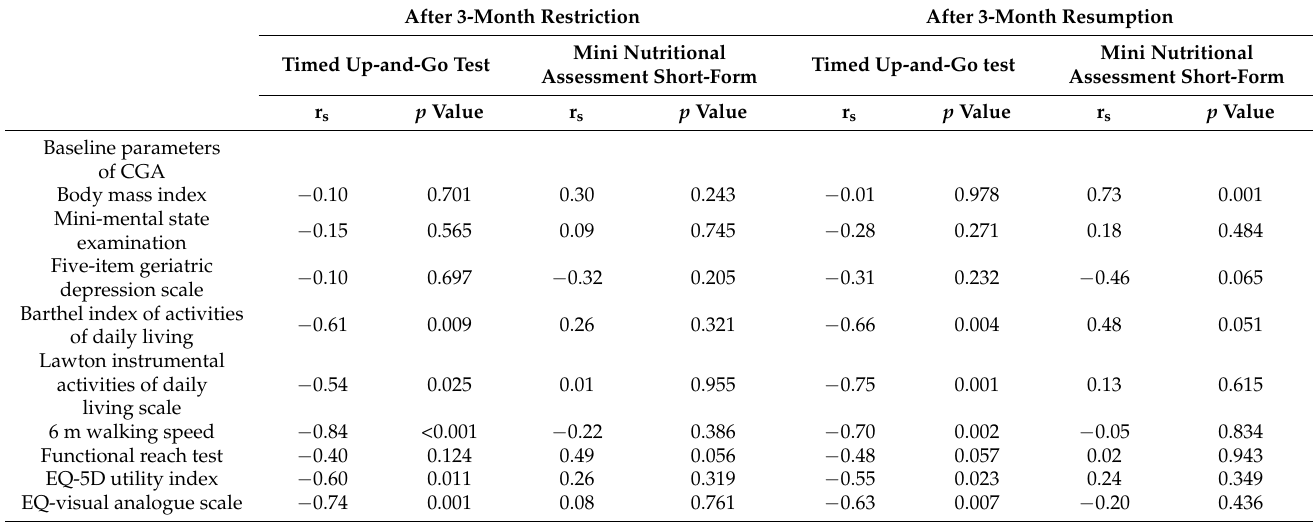
Table 3. The correlation between baseline parameters of CGA and physical and cognitive function after 3 months of daycare services restriction and